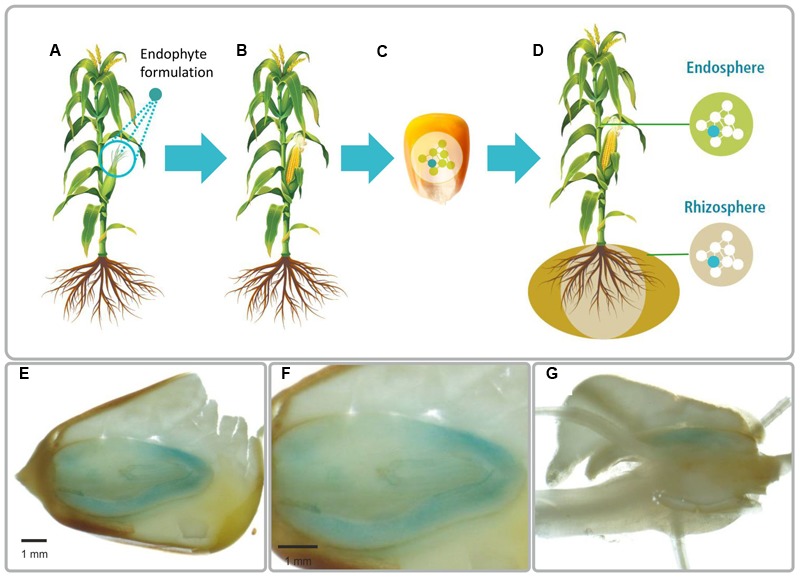
Illustration of the method to introduce plant beneficial bacteria into plant seed (A–D). (A) Plant flowers are sprayed with a bacterial suspension. (B) The bacteria colonize flowers and the developing seeds. (C) Mature seeds are collected and endophytes stay viable during seed storage. (D) Endophytes proliferate during germination and colonize the offspring plant generation. Light microscopy images of a mature maize colonized by Paraburkholderia phytofirmans strain PsJN::gusA (E–G). The blue is due to GUS-stained bacterial cells. Strain PsJN is present inside the embryo (E,F) and in radicals (G). PsJN starts moving from embryo to germinated parts (G). In the picture F, we present a zoom in of the first photograph (E).